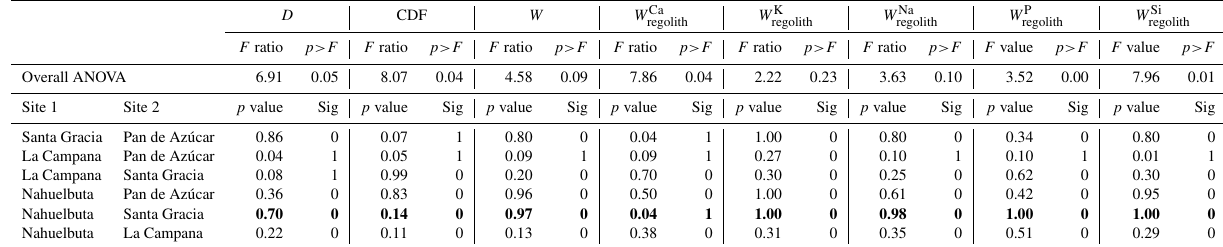
Table A6. ANOVAs evaluating variations in denudation rate ( D ), the chemical depletion fraction (CDF), soil weathering rate ( W ), and the elemental weathering rates for Ca, K, Na, P, and Si ( W Ca treated as independent from each other, n = 8). The Tukey HSD test for site comparison is shown below. Sig = 1 indicates significant differences between the sites. The comparison between Santa Gracia and Nahuelbuta is highlighted in bold because of their importance in the